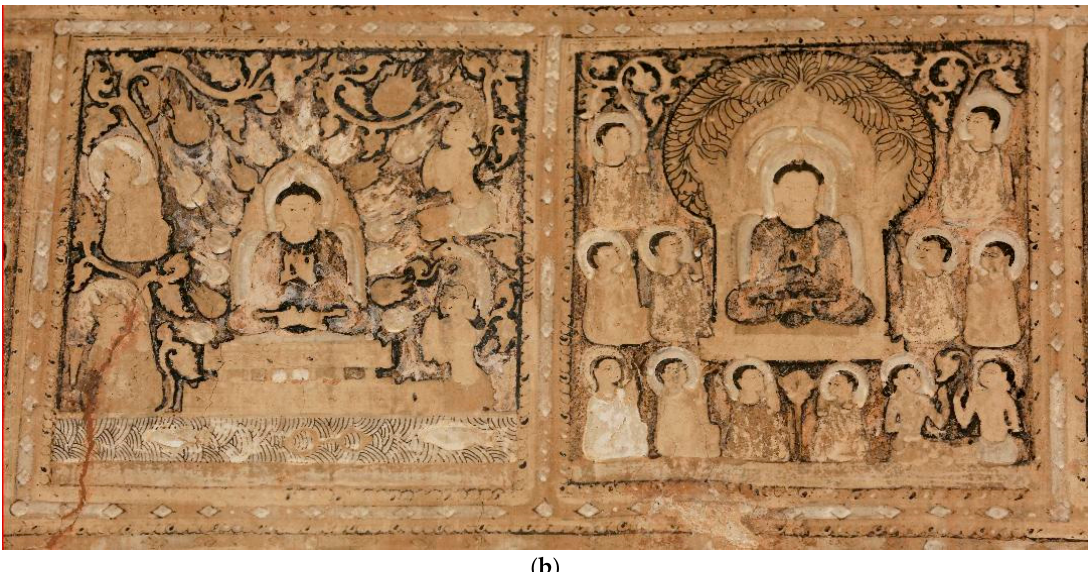
Figure 28. Nyaung U, Kondawgyi, 13th century. Four examples of the diverse audiences addressed by the Buddha, including snakes, princes and kings, monks and divinities. Inscriptions originally likely here are now missing. ( a ) Buddha addressing monks and Brahmas. ( b ) Buddha addressing nagas, monks and lay people.